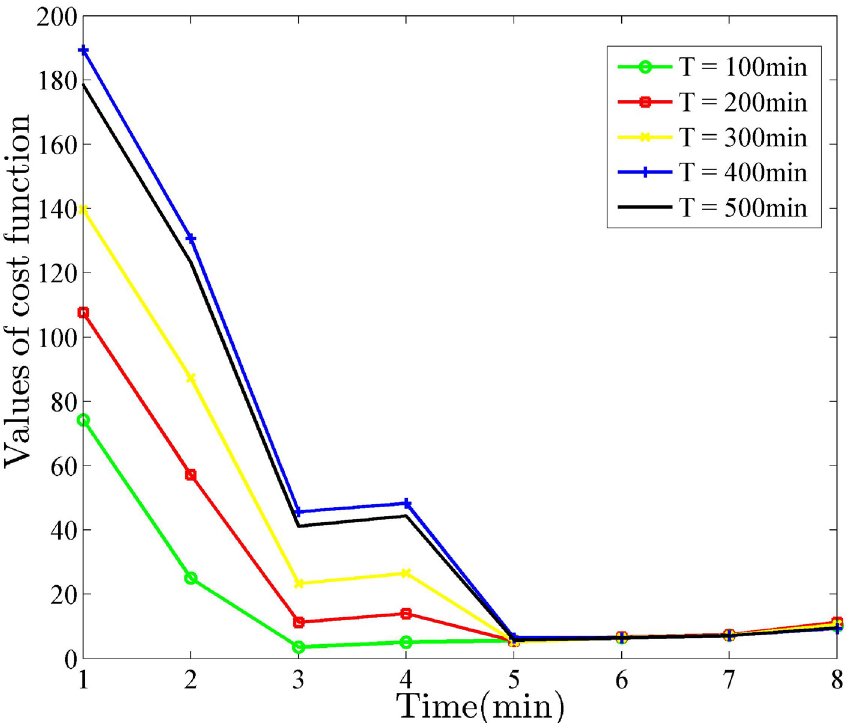
Fig 13. Cost trajectories of five periodic inputs for buffered system. Five trajectories of cost function converge to the point N = 50, indicating the amount of measurements meet the requirement of modeling.